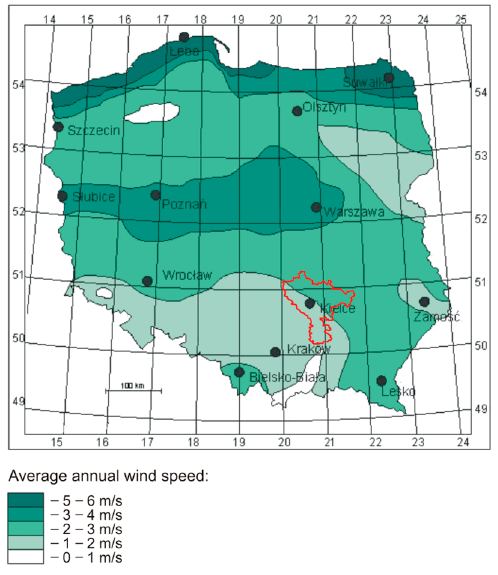
Figure 2. The wind map of Poland with a marked area of the conducted reliability tests of 110 kV lines (acc. to the Institute of Meteorology and Water Management).